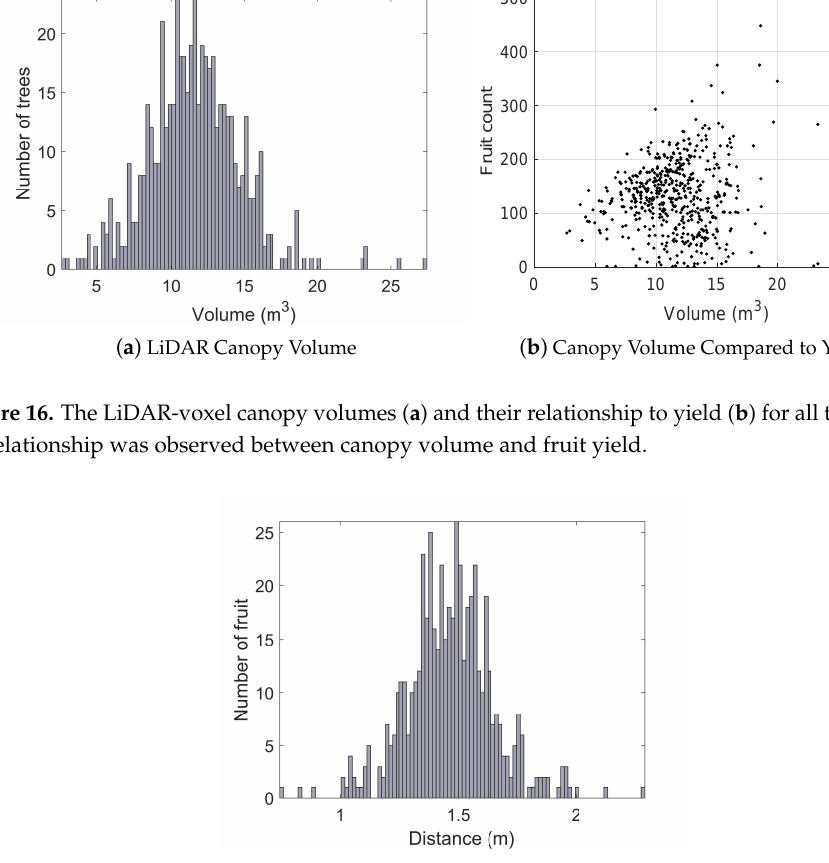
Figure 17. A histogram of the height of all fruit above the local ground surface, as measured by the